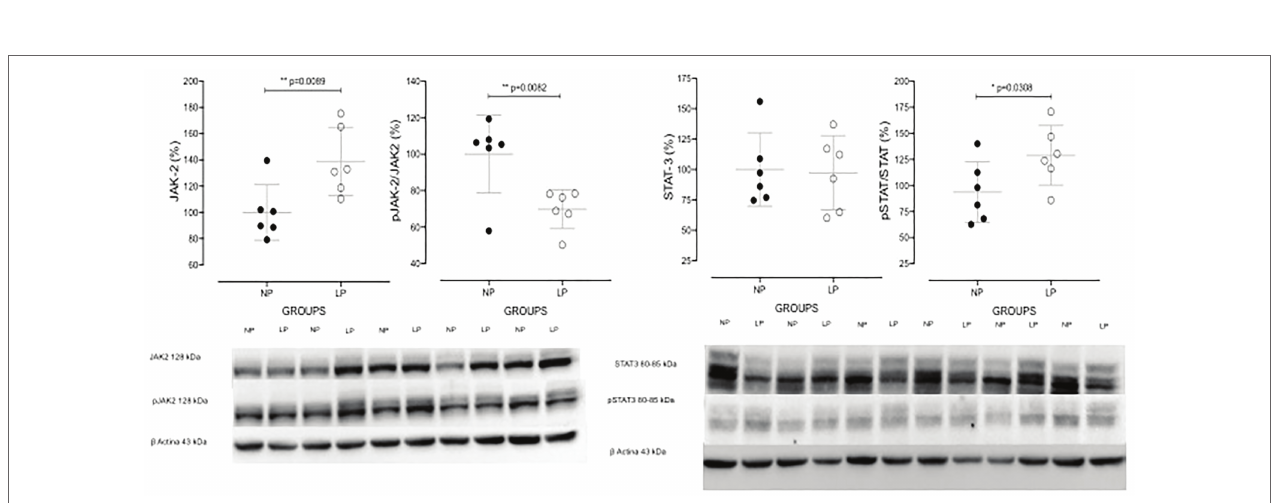
FIGURE 10 | Western blot analyses of JAK-2, pJAK-2, STAT-3, and pSTAT-3 protein expression in the whole kidneys of 24-week-old NP ( n = 5) and LP ( n = 5) offspring. Data are presented as scatter dot plots; unpaired Welch’s t -test was used for data analysis. The level of significance was set at p <